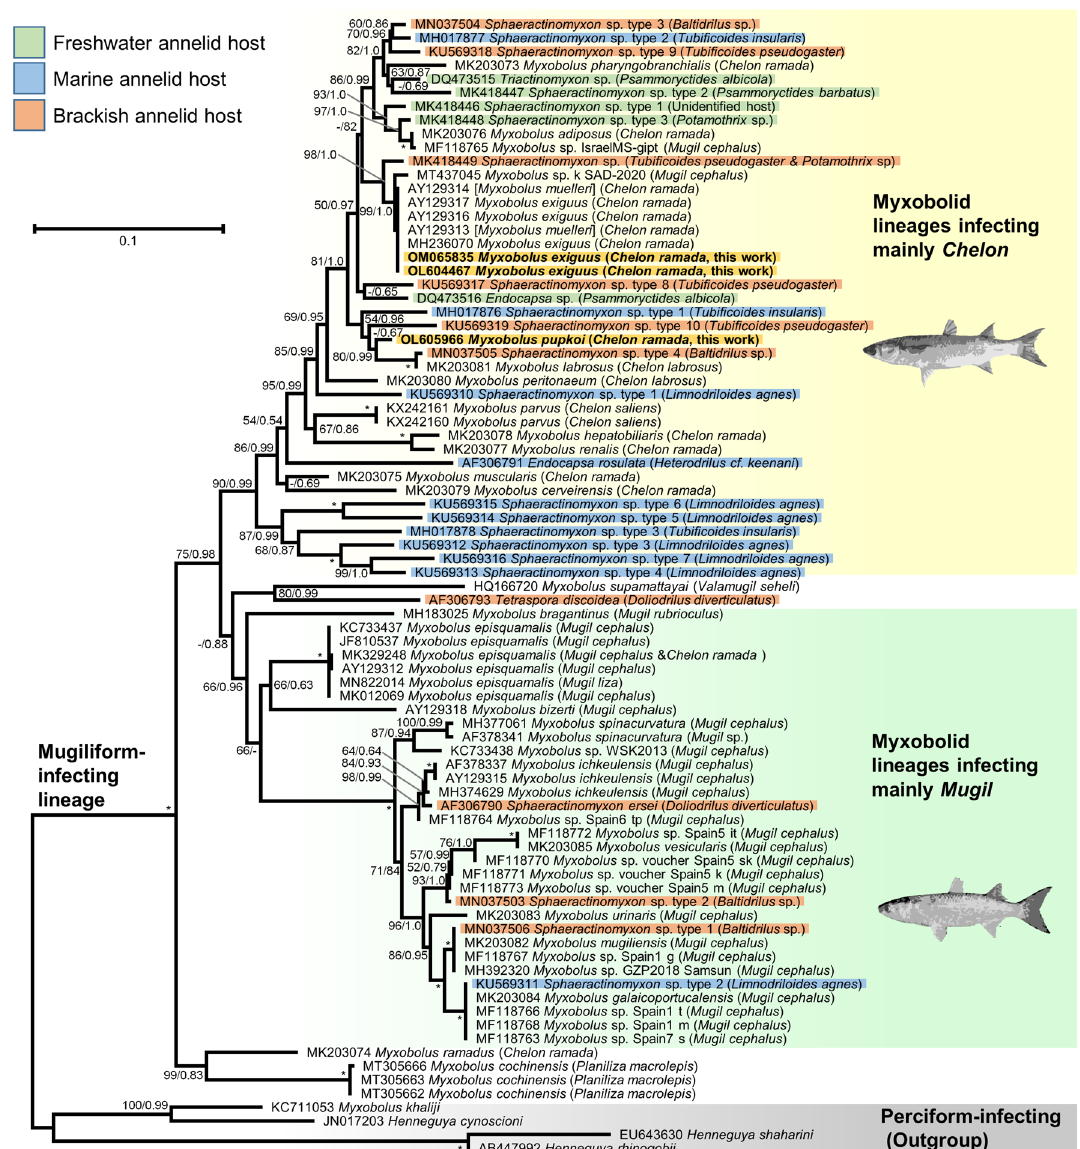
Figure 3. Phylogenetic relationships within the mugiliform-infecting lineage inferred from 18S rRNA sequences under the ML criterion (TVM + F + R3 model). The new sequences of M. exiguus (OL604467 and OM065835) and M. pupkoi (OL605966) are indicated in bold and with a yellow background. Branch supports (i.e. ML bootstrap percentages [BP] above 50/posterior probabilities [PP] above 0.5) are indicated near the corresponding nodes. Maximal support values (BP = 100/PP = 1.0) are indicated by an asterisk. A dash indicates BP < 50 or PP < 0.5. The sequences identified as M. muelleri in NCBI, but recognized to be M. exiguus 10,43 , are indicated within